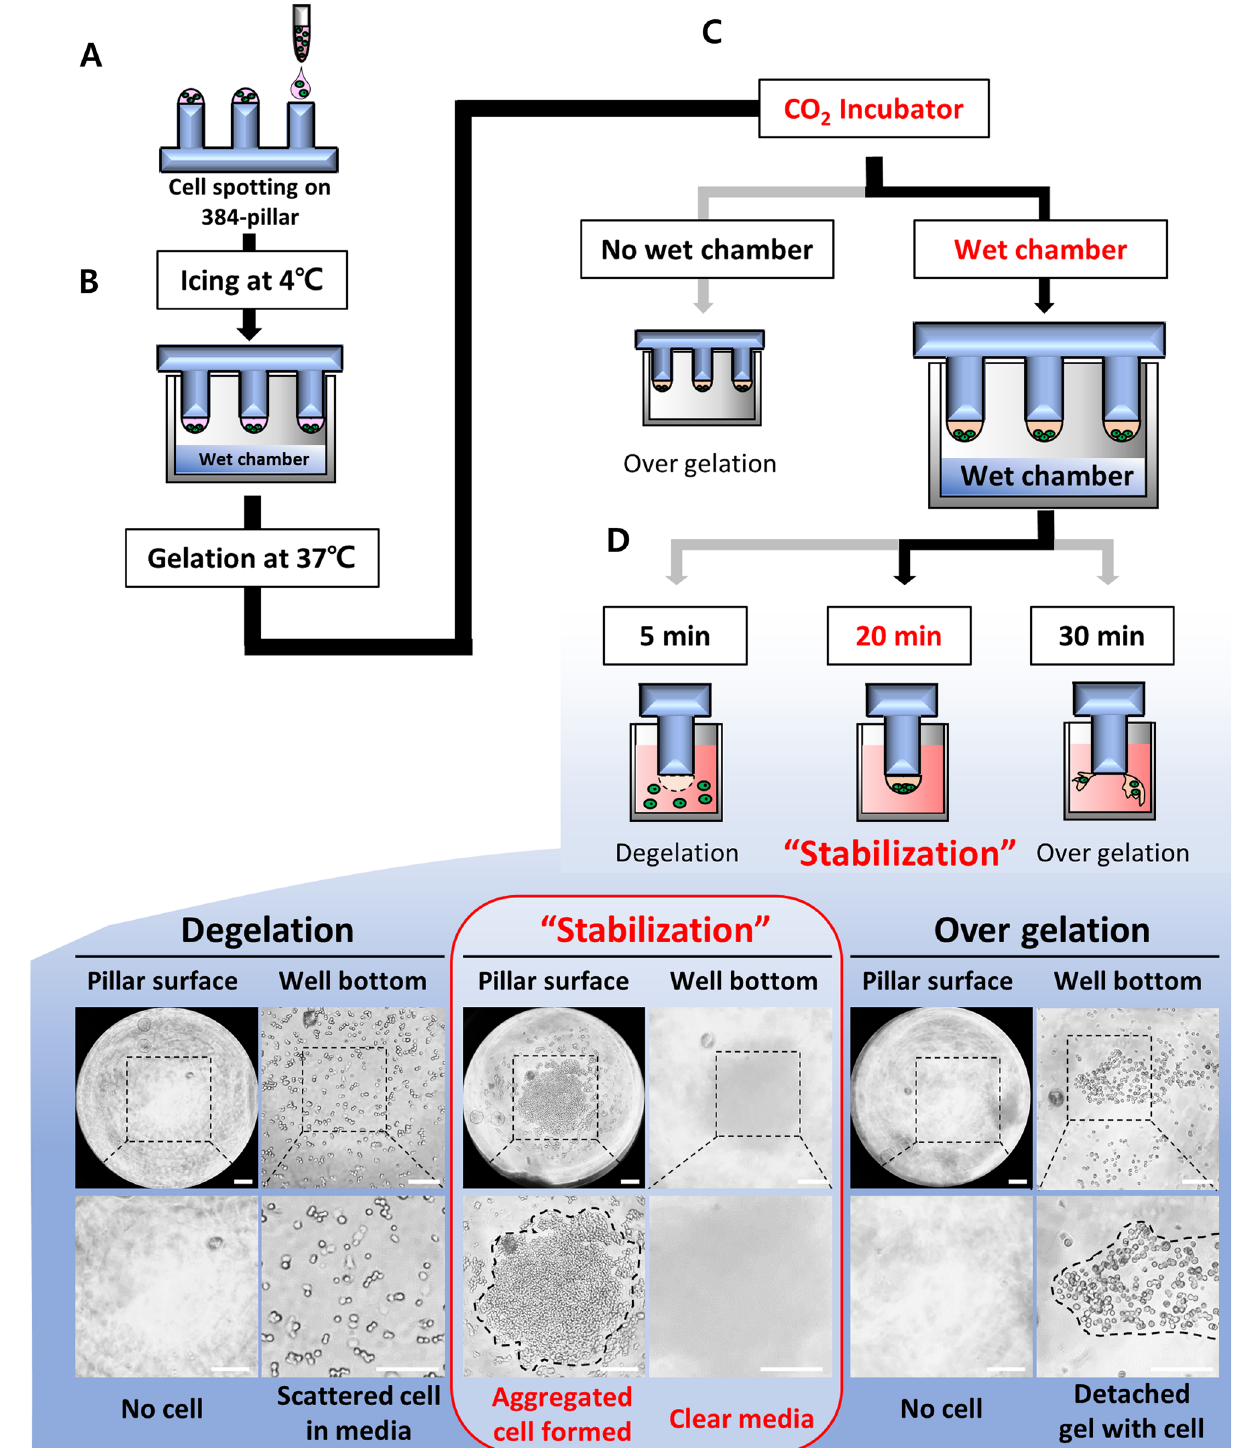
Figure 2. Optimized 3d cell culture protocol for implementing 3D-ASM. ( A ) Cell and matrigel mixture dispensed on the surface of the 384-pillar plate by 3D-Cell spotter. ( B ). The 384-pillar plate aggregates the cells into one place through storage in an ice box for 2 h while combined with the wet chamber. ( C ). In the CO 2 incubator condition, over gelation occurs if the wet chamber and the 384-pillar plate are not combined. ( D ). In humidified incubator and wet chamber conditions, the 3D-cell mixture is stabilized after gelation for 20 min. (de-gelation occurs at the 5-min condition, and over gelation occurs at the 30-min